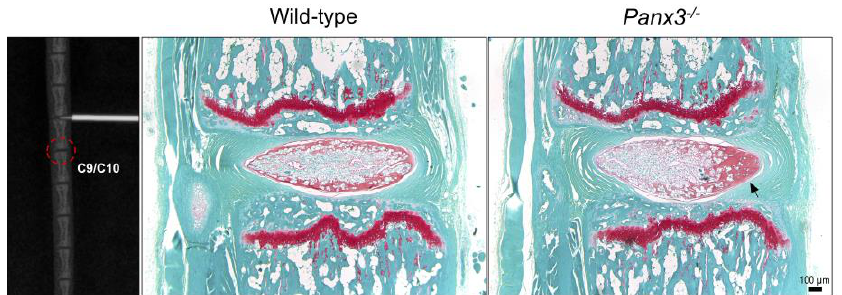
Figure 6. Degenerative changes identified in adjacent uninjured NP tissue of Panx3 -/- mice following needle puncture. Representative X-ray image demonstrating caudal IVD 8/9 undergoing needle puncture injury. Dotted red circle highlights caudal IVD 9/10 of the motion segment distal to the site of injury. Representative safranin-O/fast green-stained mid-sagittal sections of uninjured caudal IVDs distal to the punctured IVDs, harvested 6-weeks after injury. Images are representative of n = 6 mice per group. Black arrow indicates accelerated NP degeneration marked by increased matrix density and reduced cellularity.